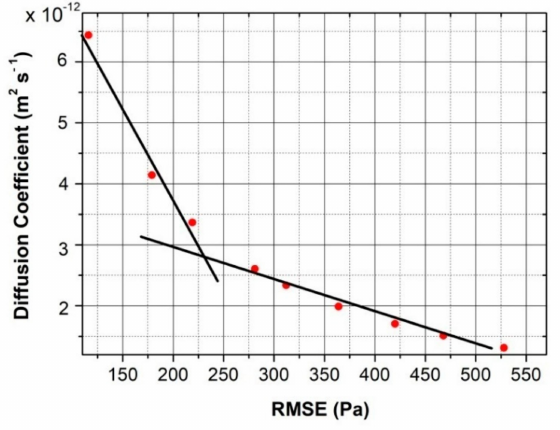
Figure 3. Relation between the root mean square error( RMSE ) and the di ff usion coe ffi cient calculated for test #7 (T = 150 ◦ C and p i = 10,390 Pa).